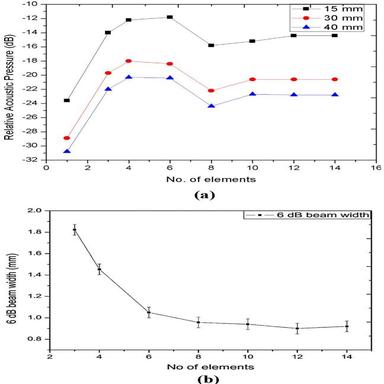
Effect of aperture size using 5 MHz, 0.6 mm pitch linear array on (a) acoustic pressure and (b) size of the virtual source.